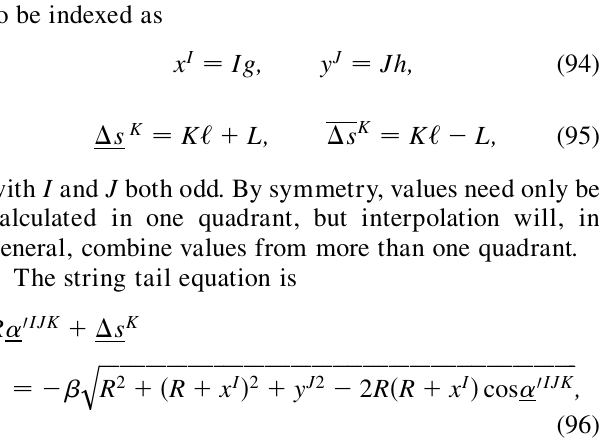
vertically. The repetition periods are 2 g horizontally and 2 h vertically, and the field grid points are staggered by a half-period in both transverse directions so they cannot coincide with the source point. The longitudinal grid spacing (not shown) is ‘